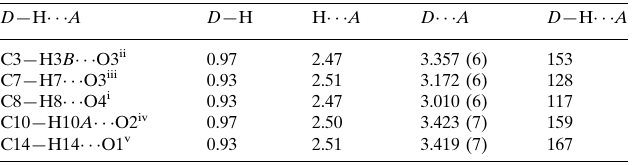
Hydrogen-bond geometry (A˚ , (cid:2) ). D —H (cid:1)(cid:1)(cid:1)